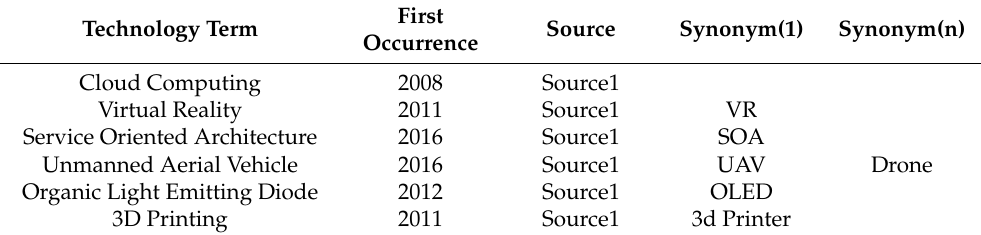
Table 1. Technology Topic